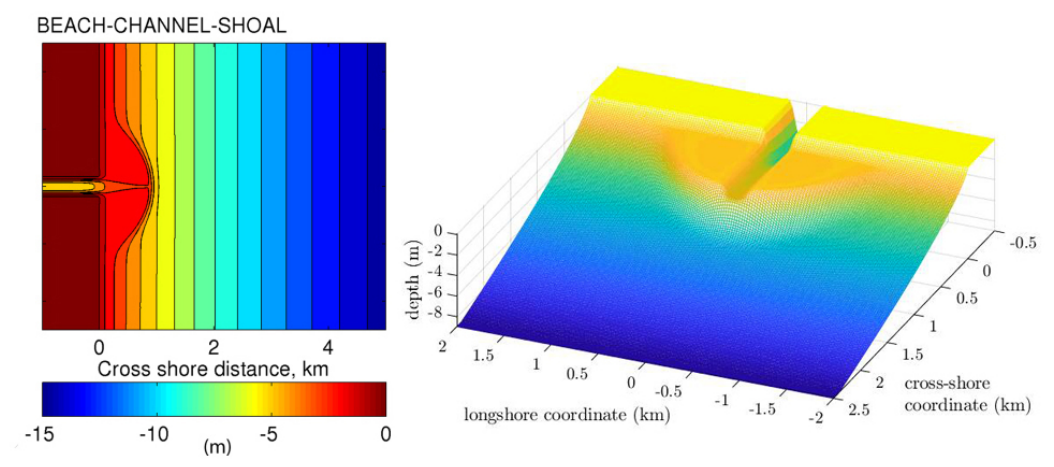
Figure 3. Sketches of a shoal bathymetry. ( Left ) plan view of the idealized configuration of an inlet mouth with shoal used in the tests by OL14 (image reprinted with permission). ( Right ) 3-dimensional view of the central portion of the shoal bathymetry used in our